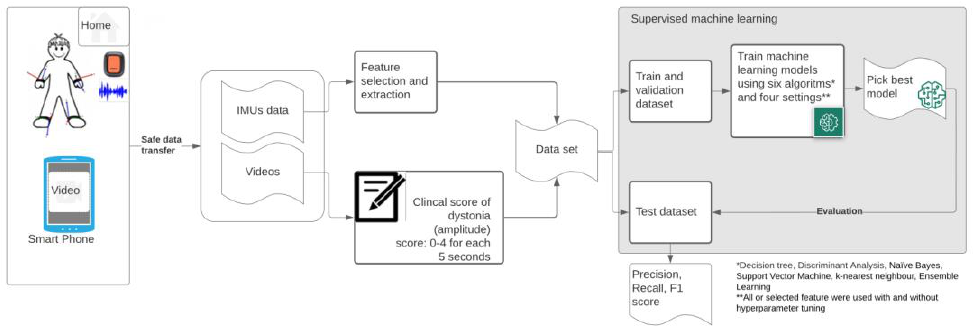
Figure 1. Flowchart of used methodology — measurements of dyskinesia at home (MODYS@home).